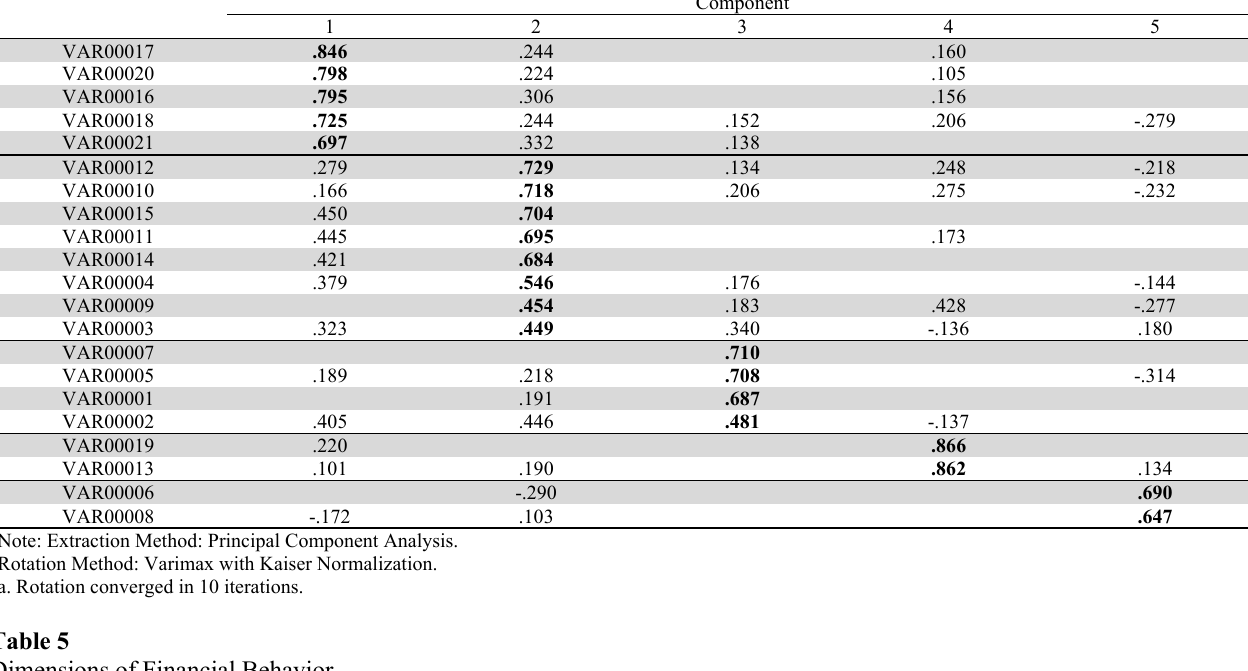
Dimensions of Financial Behavior